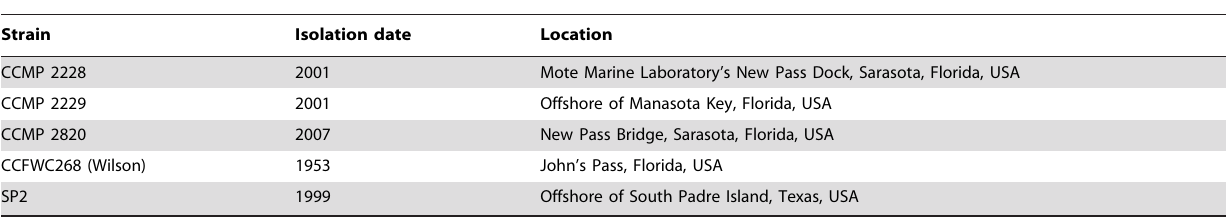
Table 2. Isolation date and location of Karenia brevis strains.